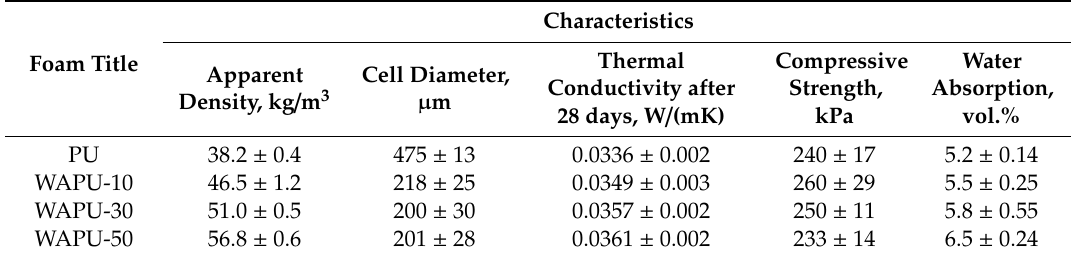
Table 2. Physical and mechanical properties of PU and WAPU